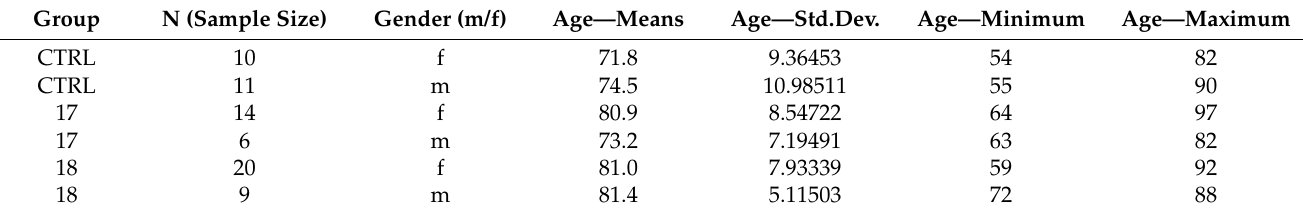
Table 1. Descriptive statistics of study